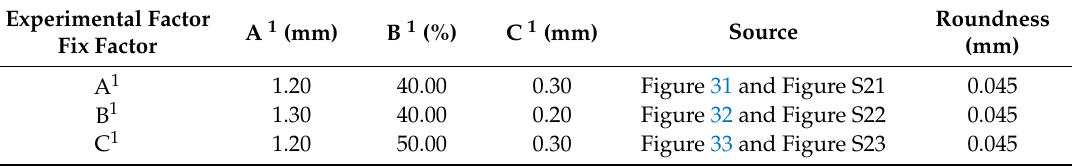
Table 8. Value of Experimental Factor for Hole 15 mm.